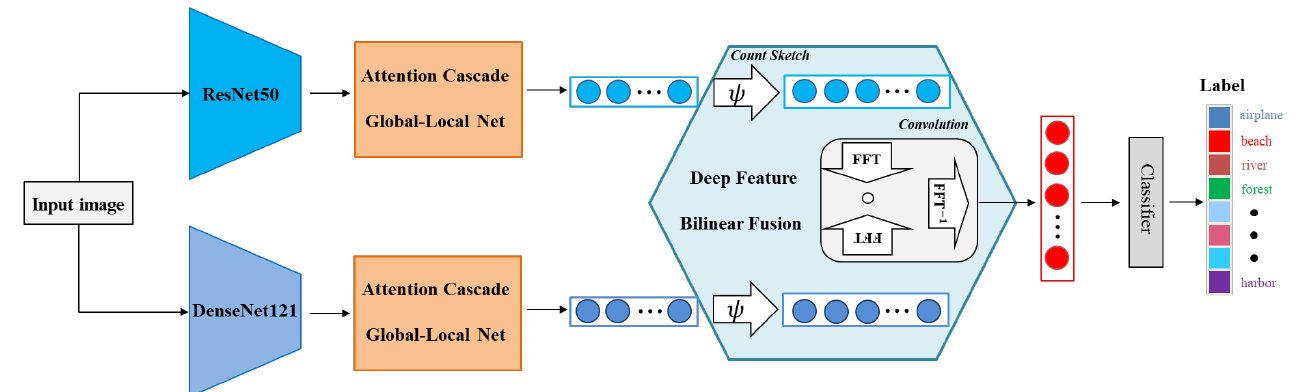
Figure 2. Overall structure of our proposed